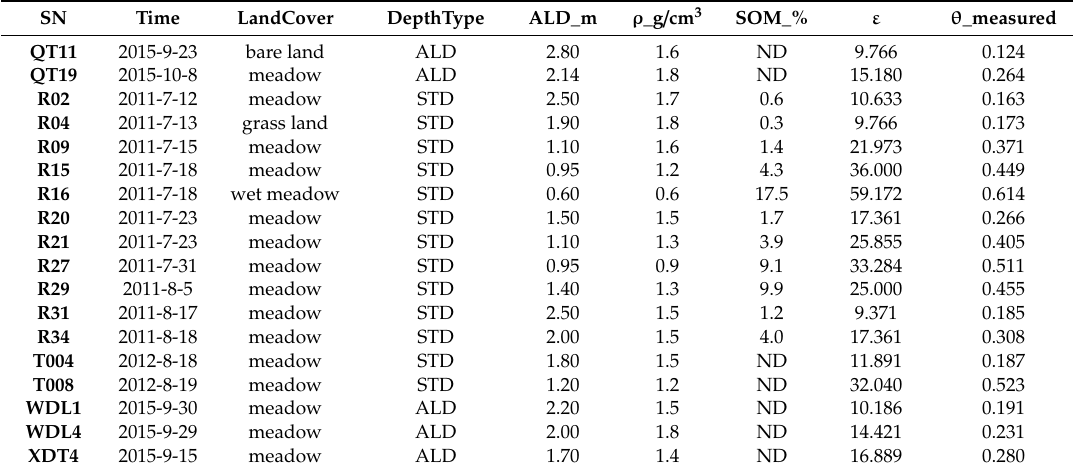
Table 1. Active-layer soil water content investigation data